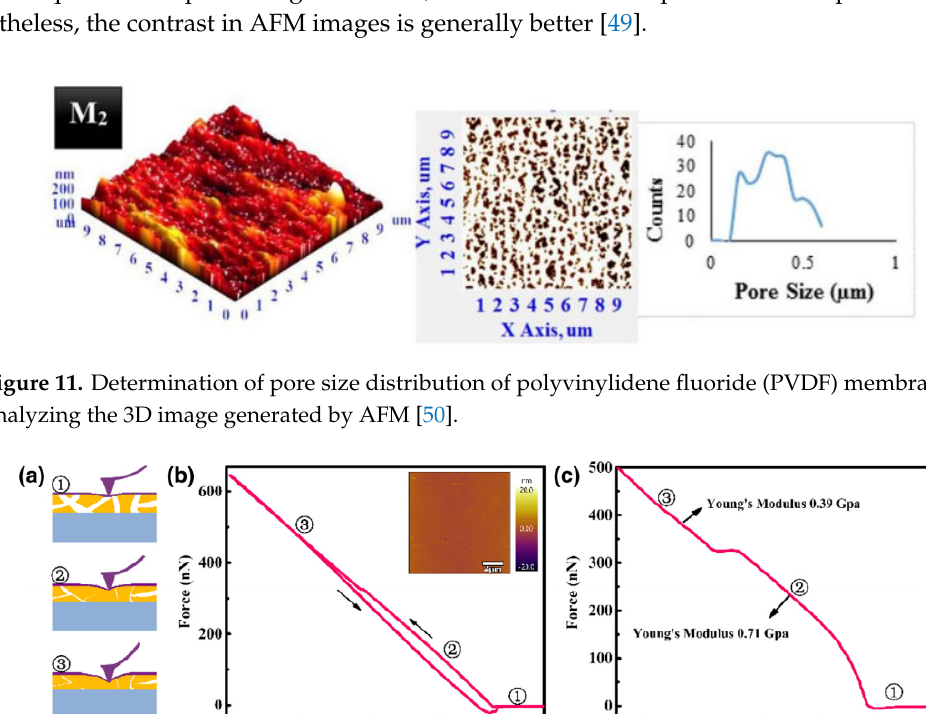
Figure 10. 3D AFM data of polyvinylidene fluoride (PVDF)/polyvinylalcohol (PA) membrane: (a) Original surface, (b) surface after fouling due to the exposure to natural organic matter (pH3) [46].